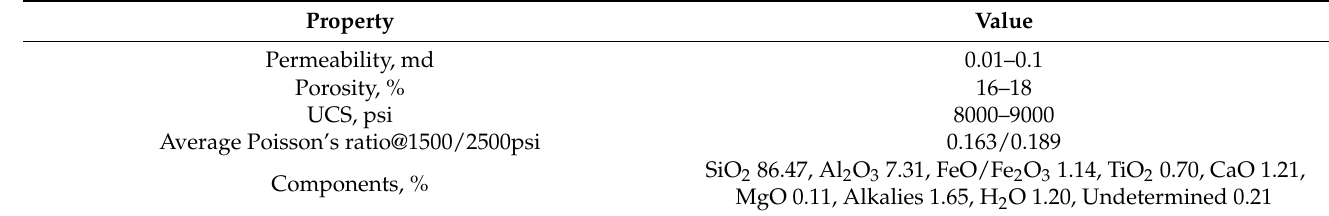
Table 1. Core properties of Ohio